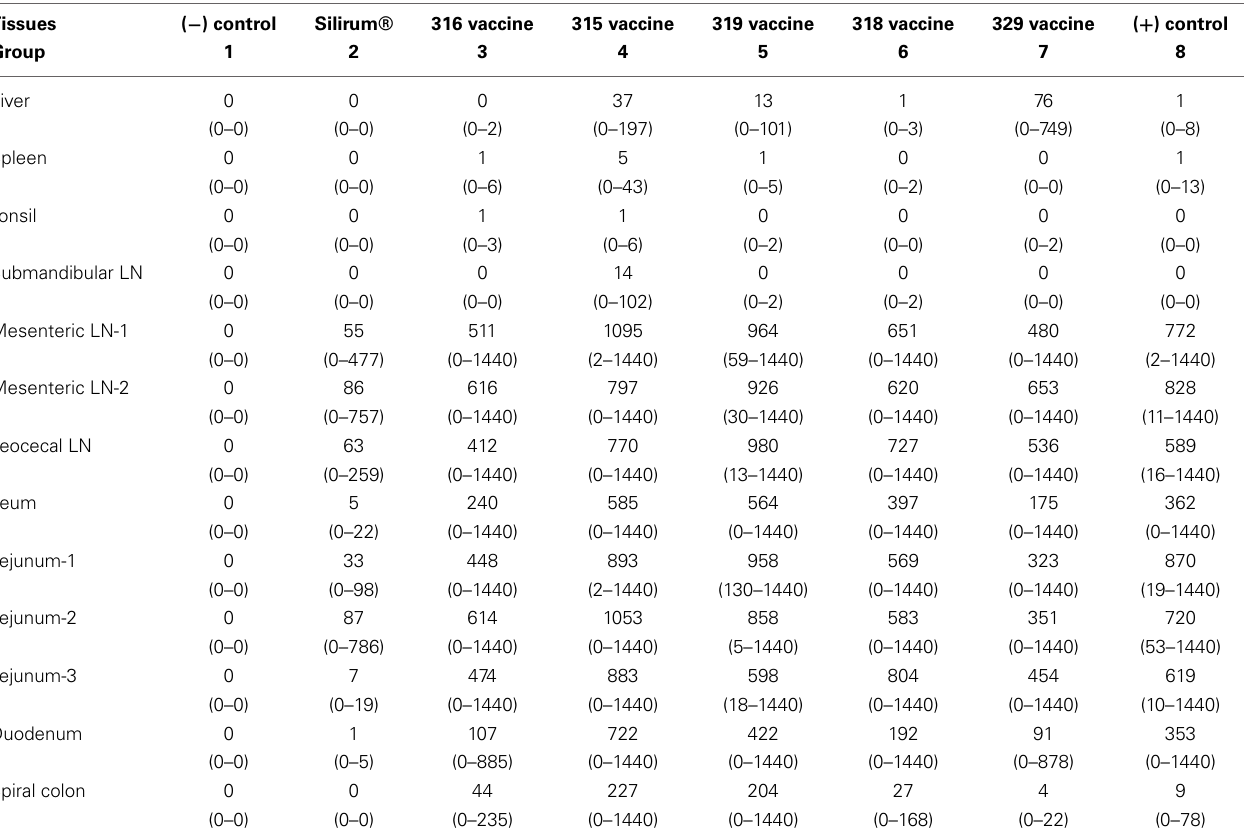
Table 4 | HEYM tissue culture (CFU/gm) means and ranges, by vaccine group (rounded to nearest whole number). Tissues